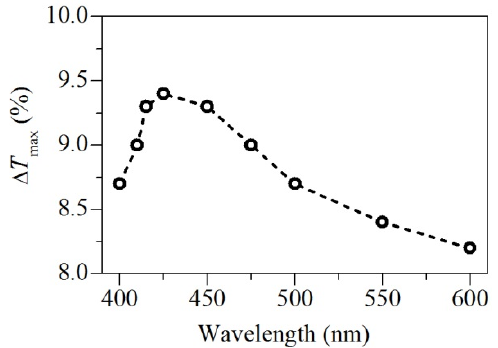
Figure 4. Calculated changes of transmittance of 7-layer Bragg stacks comprising of dense and porous Nb 2 O 5 layers having stop bands at different wavelengths when refractive index of all porous layers increases by 0.03.